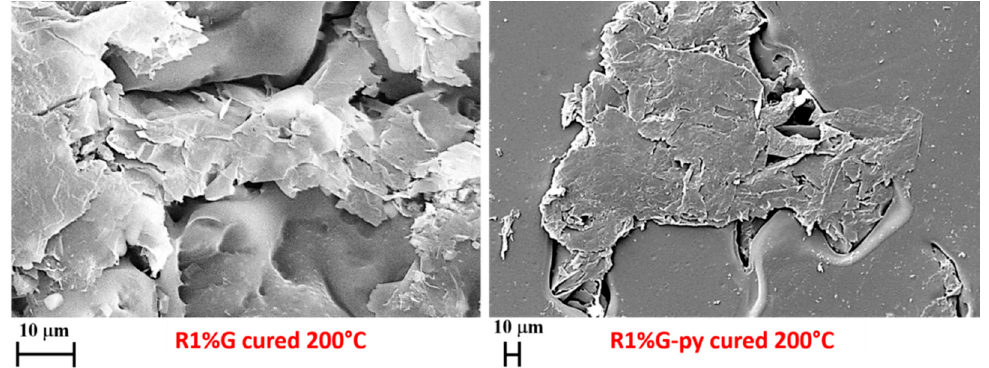
Figure 4. FESEM pictures of the samples R1%G and R1%G-py cured up to 200 °C.